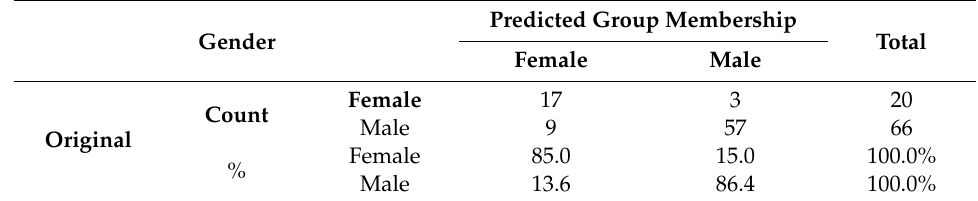
Table 6. Classification results a .